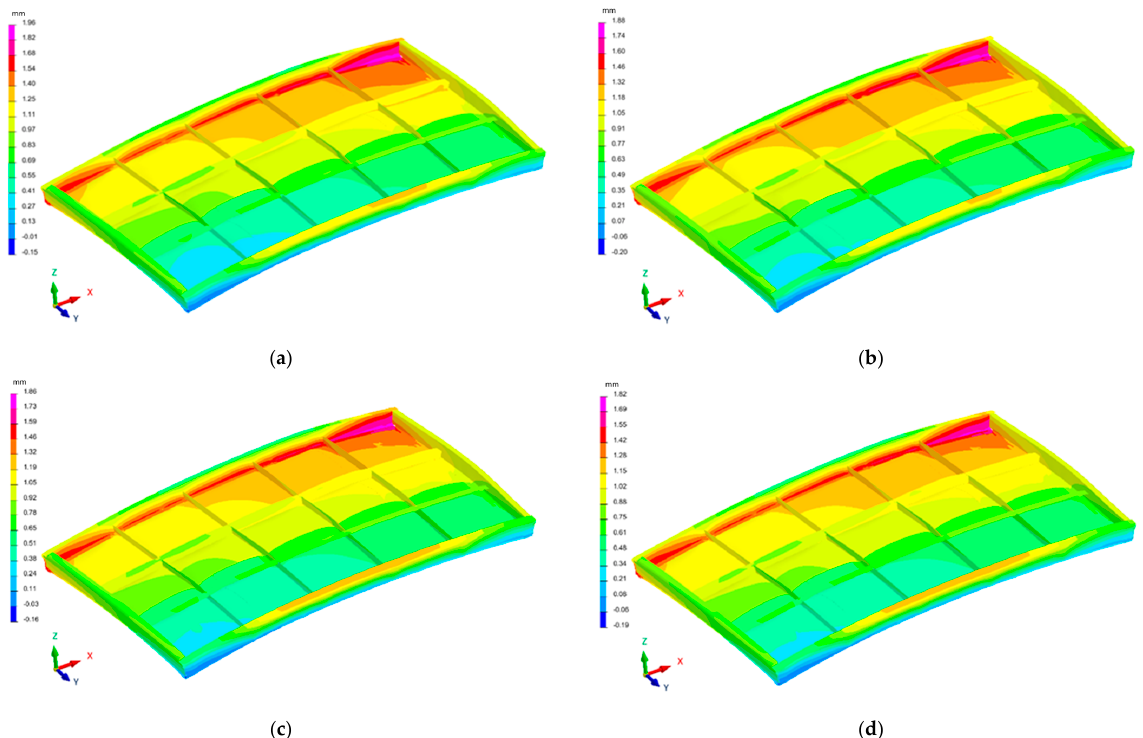
Figure 11. Distribution of the strain field of the industrial furnace wall panel in the Y direction; ( a ) 1st restraint model, ( b ) 2nd restraint model, ( c ) 3rd restraint model, and ( d ) 4th restraint model.